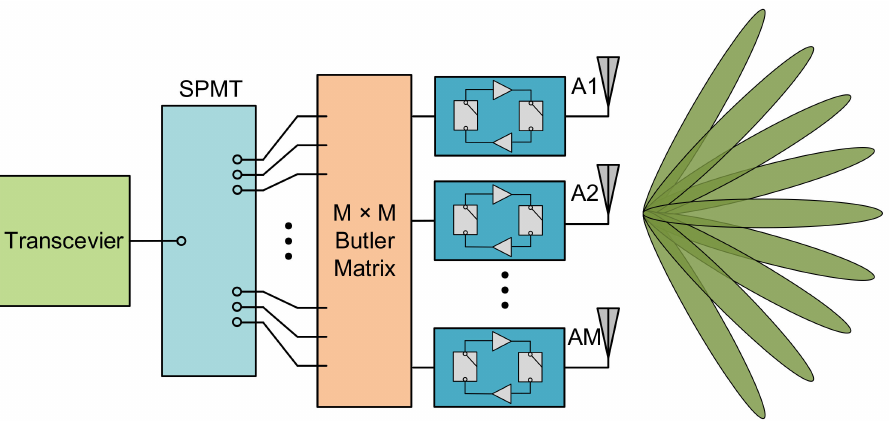
Figure 1. Structure block diagram of a single-pole multi-throw (SPMT) switch used in an analog beamforming system with a Butler